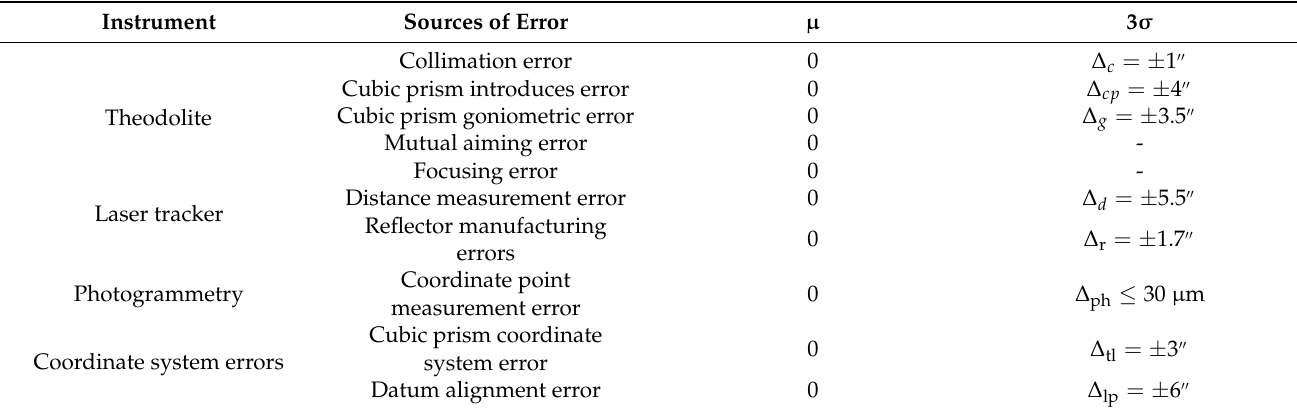
Table 4. Datum transfer error estimation and assignment.